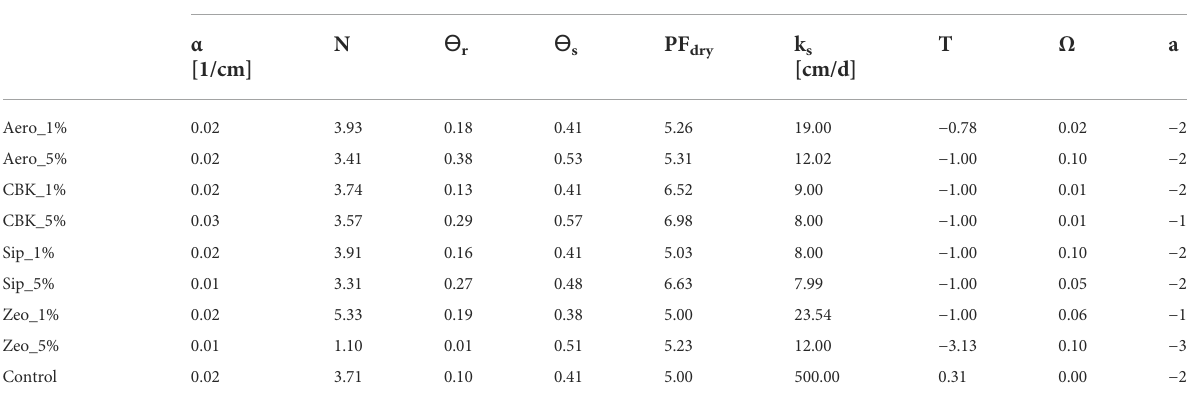
TABLE 2 The Peters – Durner – Iden (PDI) model parameters describing retention curve and hydraulic conductivity curve of sandy soil treated with different ASi contents. Treatments